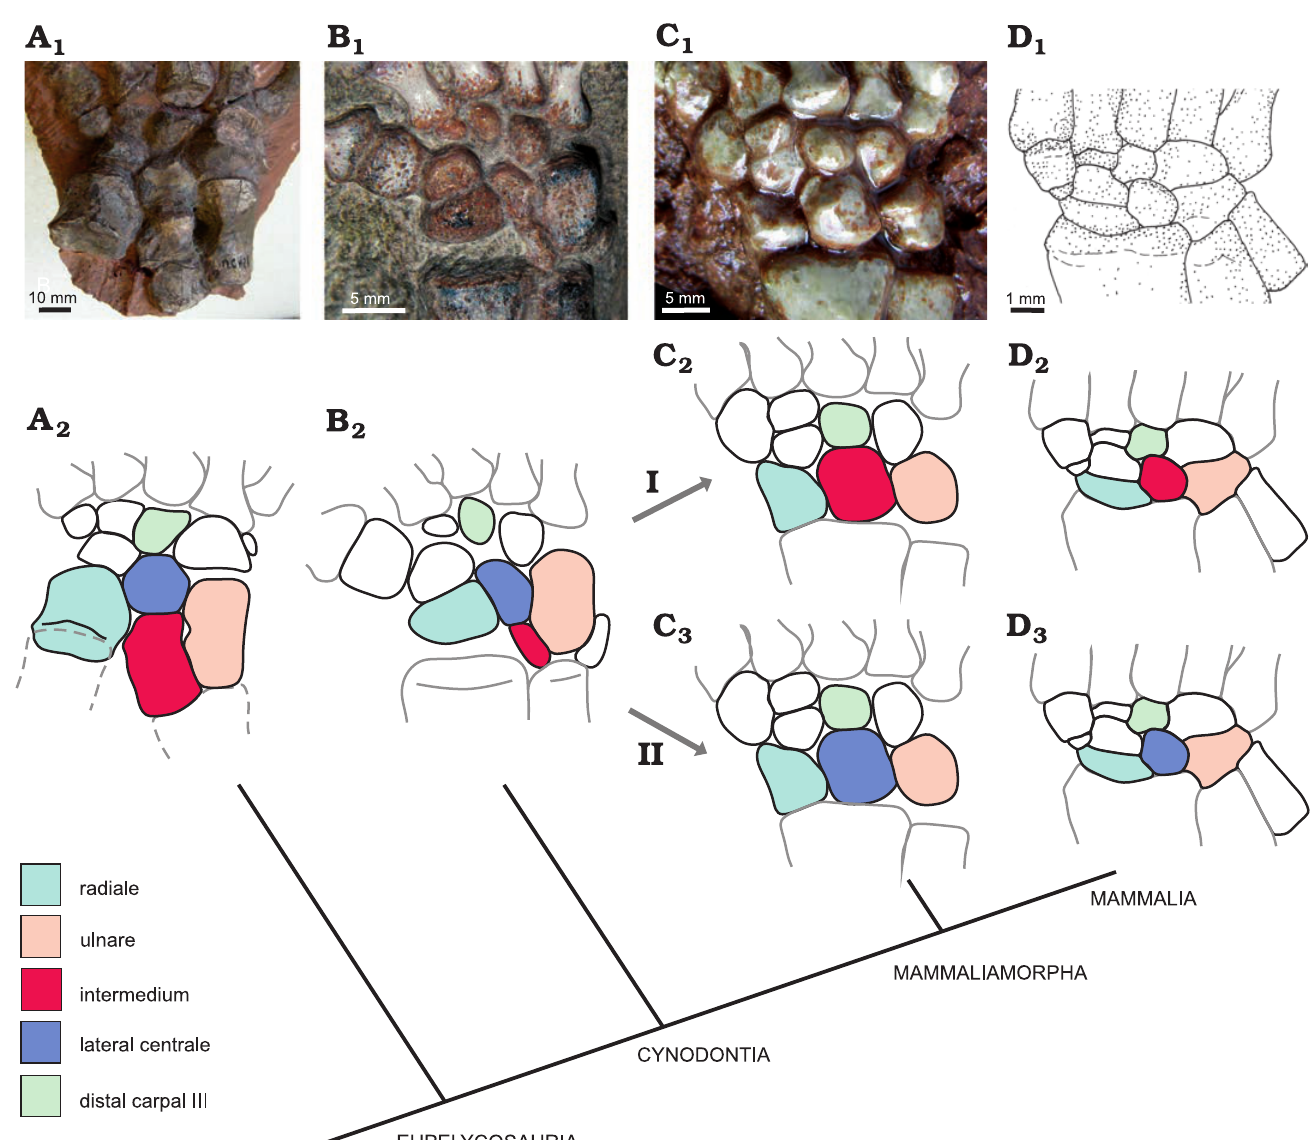
Fig. 13. Homologization of the mammaliamorph lunate with the intermedium or lateral centrale of non-mammaliamorph synapsids. I . The homologue of the lunate is the intermedium (C 2 , D 2 ); this is the traditional view (Gegenbaur 1864; Romer and Parsons 1977; Kivell 2016) and was put forward by Broom (1901) for non-mammaliamorph therapsids and extant mammals. II . The homologue of the lunate is the lateral centrale (C 3 , D 3 ) as suggested here. A . Ophiacodon (FMNH UC 458). B . Galesaurus (SAM-PK-K10465). C . Tritylodontid (WCW-06A-34). D . Zhangheotherium (IVPP V7466). Photographs (A 1 –C 1 ), drawing (D 1 ), and explanatory drawings (A 2 –D 2 , C 3 , D 3 ). The figures show the right manus in dorsal view, except for A, where the left manus has been lateromedially